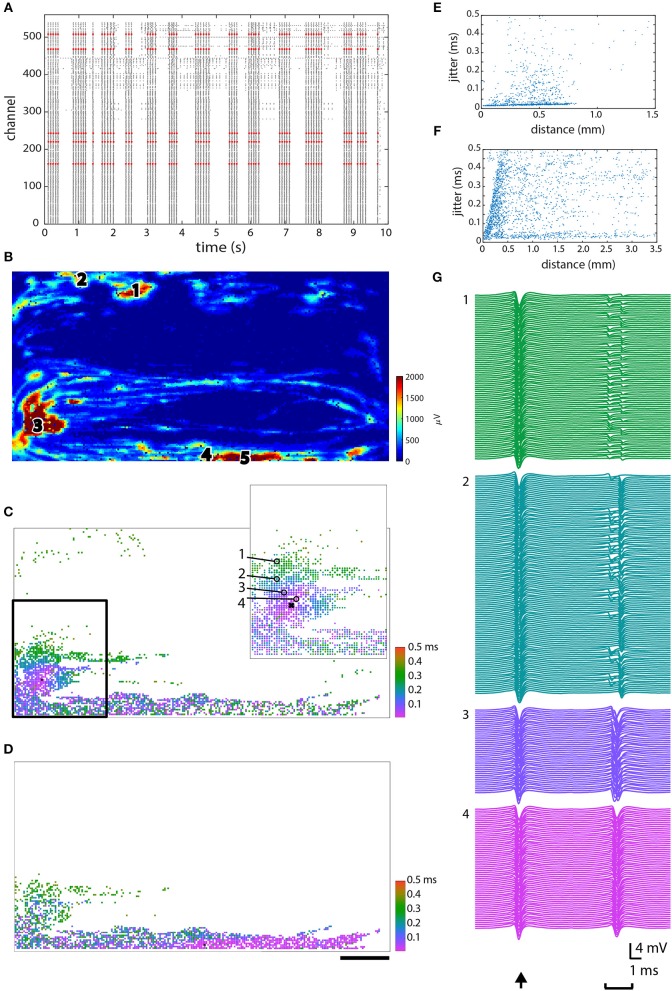
Jitter analysis. (A) Raster plot showing 10 s of data, with the five electrodes in high spiking areas that were chosen for further analysis plotted in red. (B) Spatial configuration demonstrating where each of the chosen electrodes was located. (C,D) The jitter on electrode 3 and 4, respectively, as indicated in (B). (E,F) Jitter vs. distance plotted for electrodes 2 and 3, respectively, as indicated in (B). (G) Signals from the circled electrodes (1–4) in C inset vs. the “zero point” that signals were aligned to (indicated with an “x”), to demonstrate the actual measured jitter, as shown in (C). Scale bar in D is 0.5 mm and applies to (B–D).